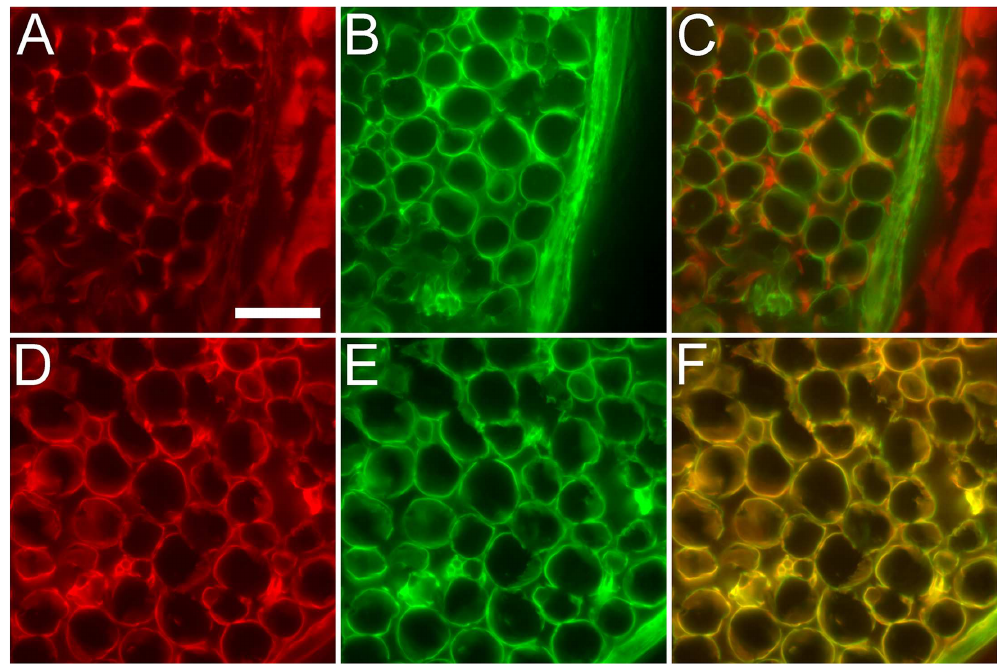
Fig 2. Endoneurial distribution of Δ CS-Aand Δ CS-Crelativeto laminin in normal rat peripheral nerve. Normalrat sciaticnerve was subjected to chondroitinase ABC treatment and doubleimmunolabeledwith antibodies againstlaminin-1andeither Δ CS-A(C4S antibody)or Δ CS-C(C6S antibody). (A) C4S immunolabelingwas present withinthe endoneurium but appearedto be isolatedto the outside of the endoneurial tubes and seemedto be absent from the perineurium. (B) Immunolabelingfor lamininrevealedring-likestructures withinthe endoneurium that representthe boundaries of basallaminatubes. Lamininwas alsopresent withinthe perineurium. (C) Combining both (A) and (B) provideda complementary patternwherethe C4S (Red) immunoreactive areas were distinct and separate from the laminin(Green)immunoreactive rings of the basallamina tubes. (D) C6S immunolabeling revealed a pattern that more resembled the ring-likelamininstructures of the basal lamina(E). (F) Combiningboth (D) and (E) confirms that both components colocalize to the basallaminatubes of the endoneurium. Scale bar: 20 μ